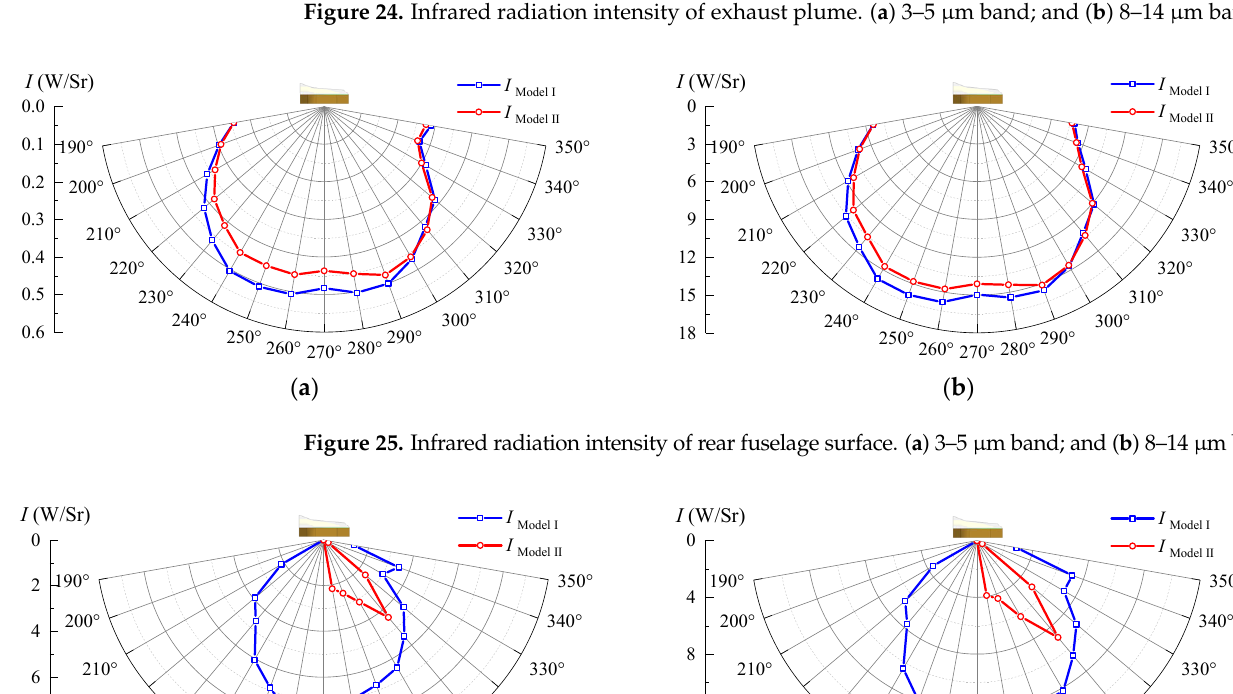
Figure 25. Infrared radiation intensity of rear fuselage surface. ( a ) 3–5 µm band; and ( b ) 8–14 µm Figure 26. Infrared radiation intensity of mixing duct. ( a ) 3–5 µm band; and ( b ) 8–14 µm band. band.